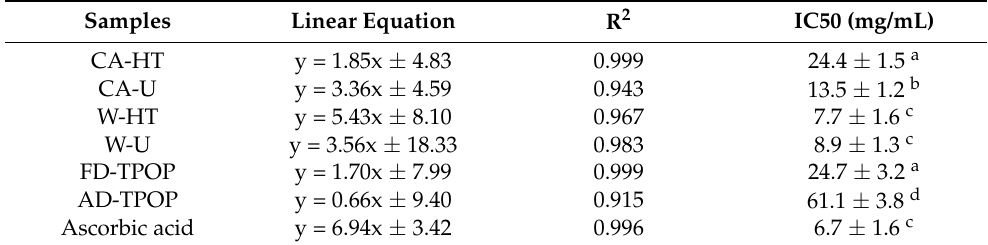
Table 4. Linear regression (%DPPH radical inhibition versus mg/mL antioxidant concentration) and IC50 value of functional beverages, dried two-phase olive pomace and ascorbic acid. The IC50 of samples was expressed as mg/mL CAE. Different letters within columns indicate a significant difference at p ≤ 0.05.